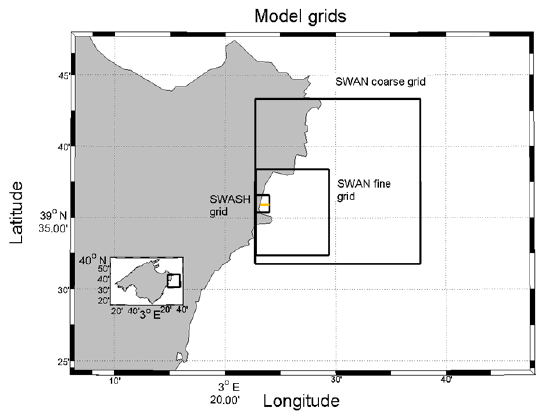
Figure 3. SWAN and SWASH computational domains for the Cala Millor beach. Yellow line indicates the sector where the three AD- CPs are located.